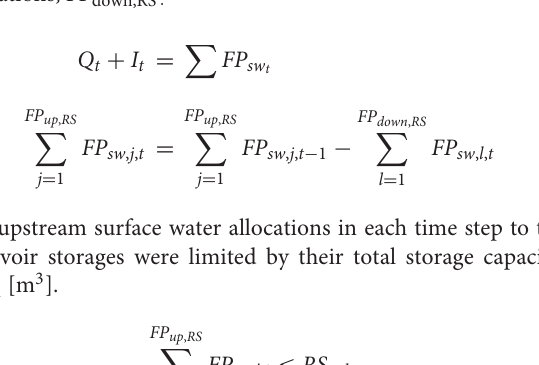
Frontiers in Water |